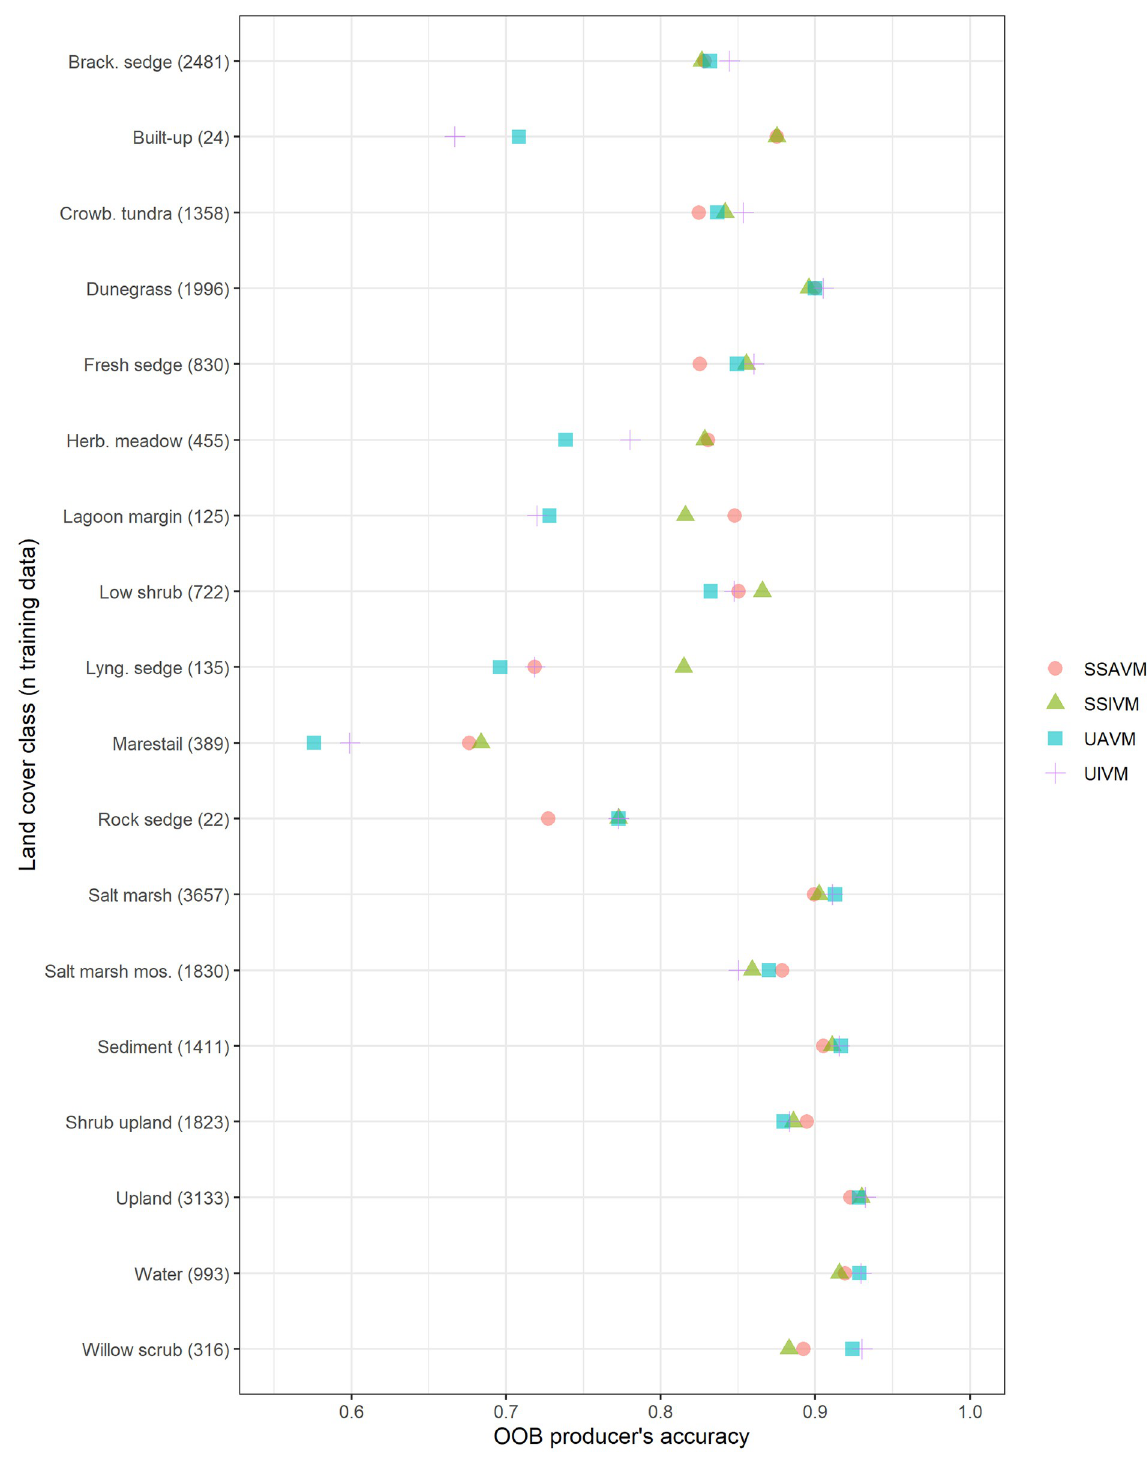
Fig 6. OOB producer’s error for the four modeling approaches, subdivided by land cover class. Land cover classes are ordered alphabetically. The n of training data is presented in parentheses.